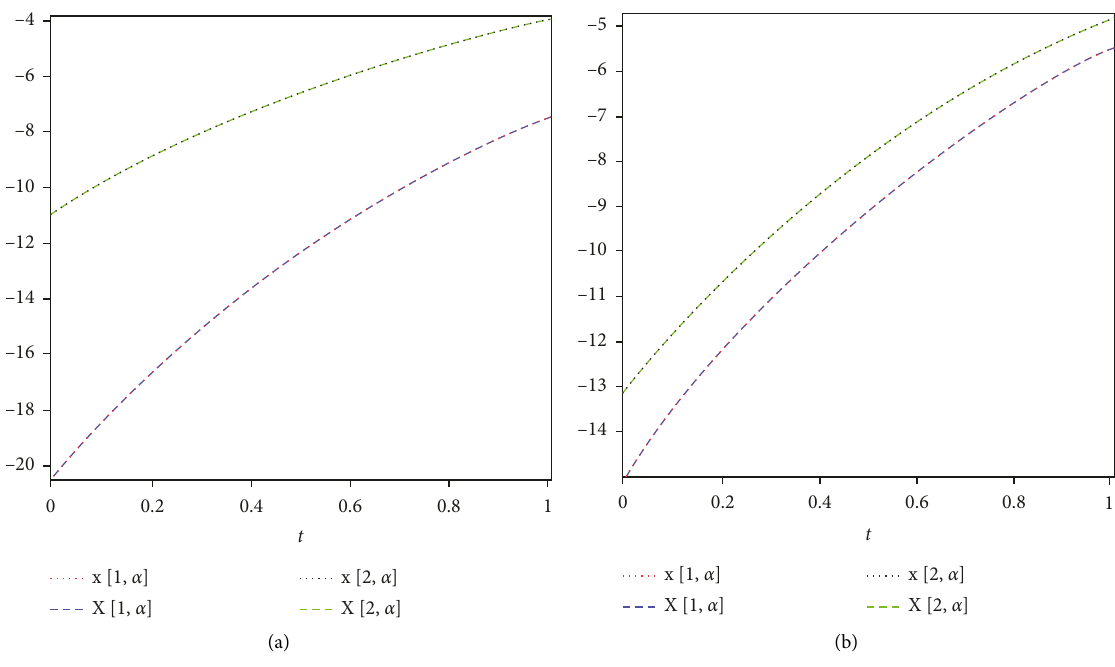
Figure 1: Comparison of the approximate X